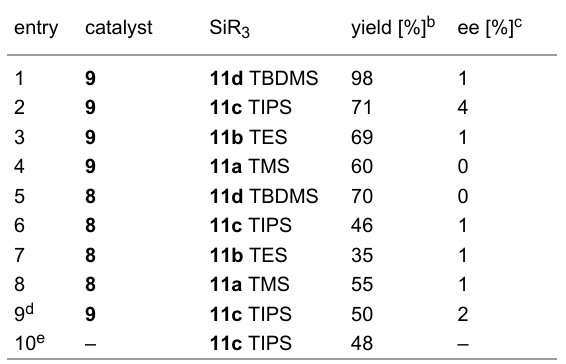
Table 11: Hydrogen-bond-catalyzed addition of silyl ketene acetals 11a – d with chromone 20 to product 22 with chlorosilanol 8 and silane- diol 9 in toluene a (Scheme